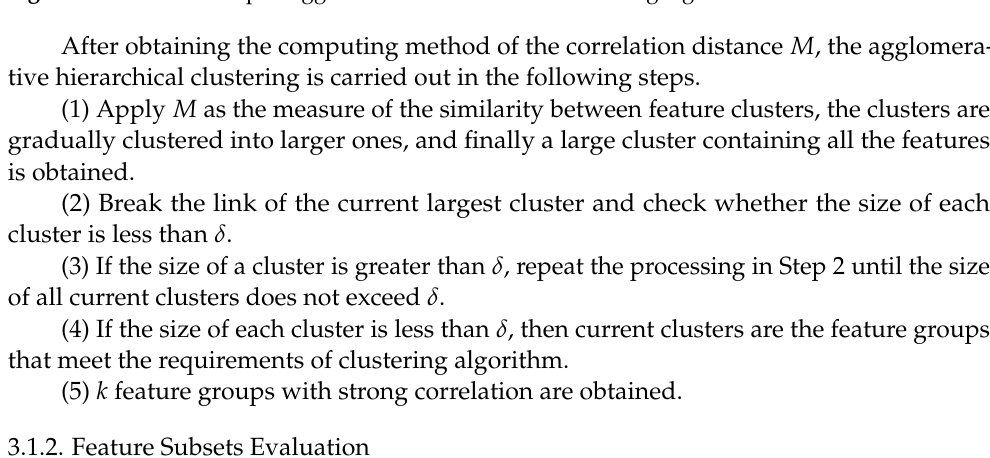
Figure 4. The sketch map of agglomerative hierarchical clustering